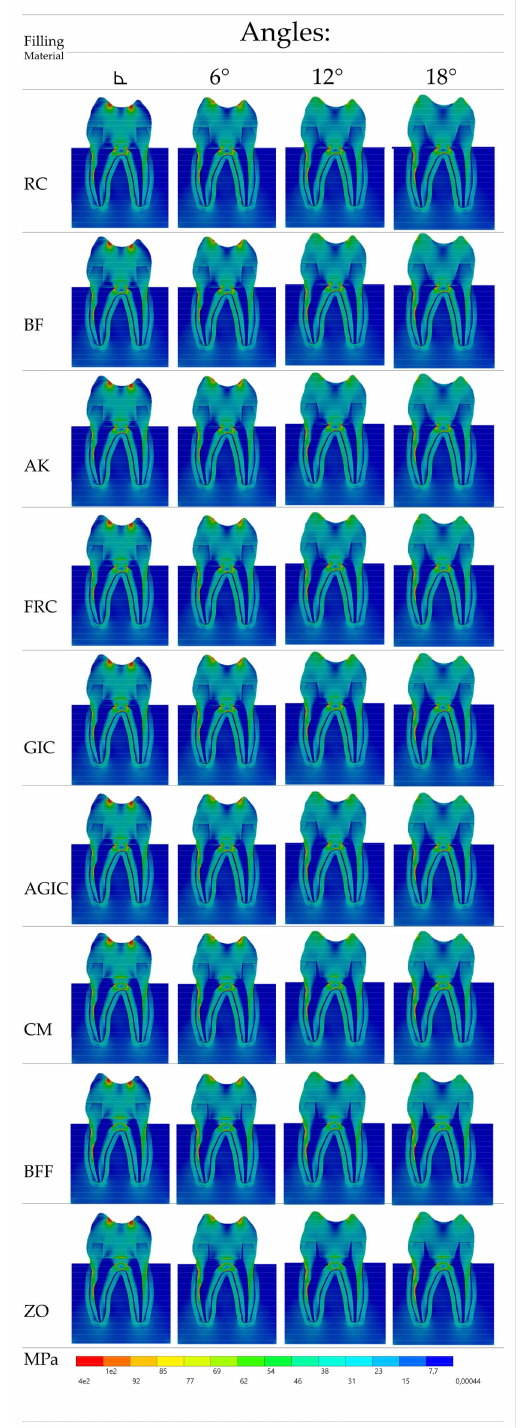
Figure 2. Von-Misses stress distribution in the endocrown section plane according to the pulp chamber axial walls angle (columns) and restorative material (rows). The corresponding filling materials are: resin composite, bulk-fill resin composite, alkasite, flowable resin composite, glass ionomer cement, autocured resin-reinforced glass ionomer cement, resin cement, bulk-fill flowable resin composite, and zinc oxide